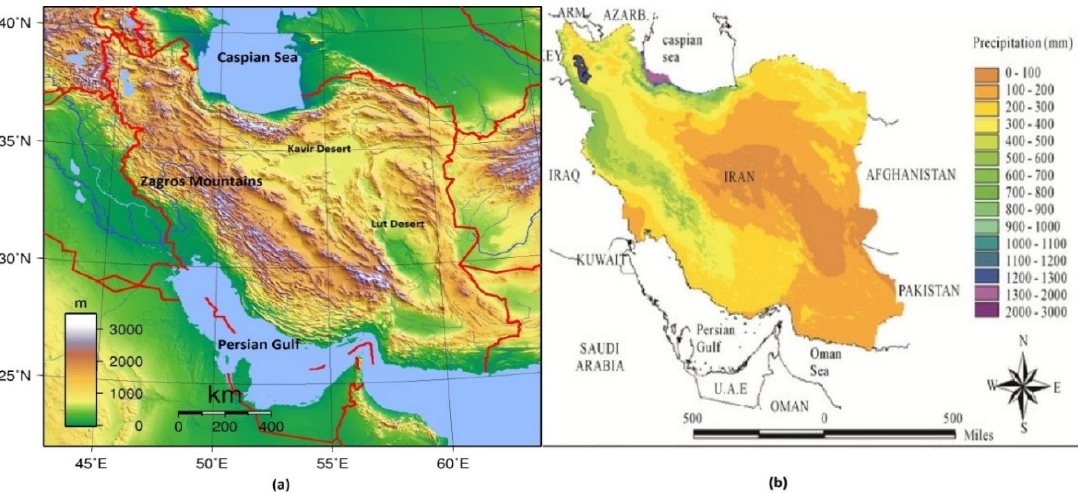
Figure 2. ( a ) Elevation map of Iran; ( b ) mean annual precipitation (mm) across Iran, 1961–1990 [11].